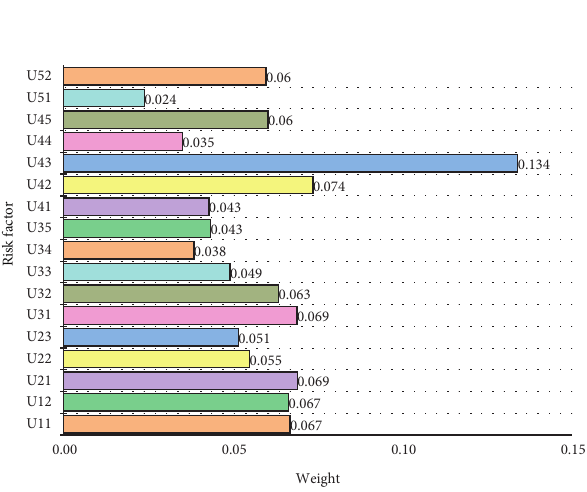
Figure 8: Objective